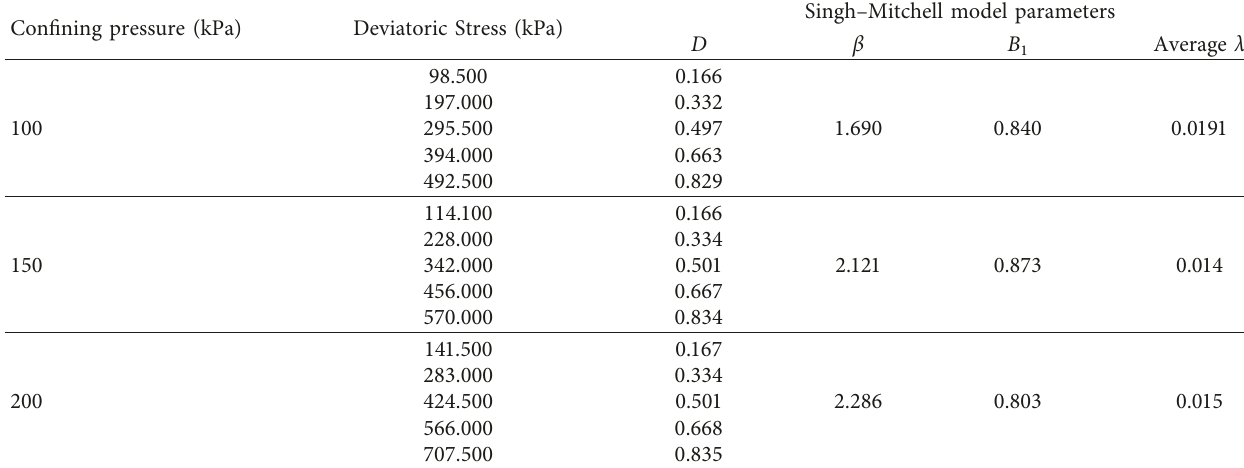
Table 4: Singh–Mitchell model parameters of the BRM under different confining